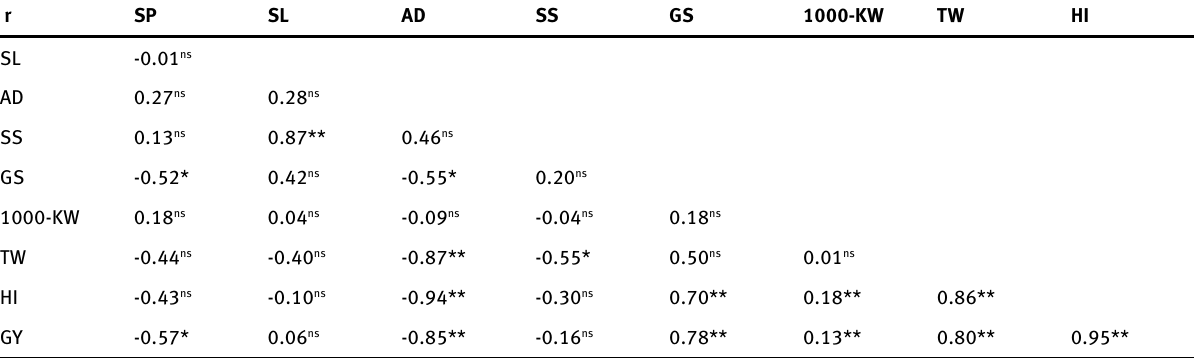
Table 4: Correlation coefficients (r) for nine agronomic traits in Triticale genotypes r